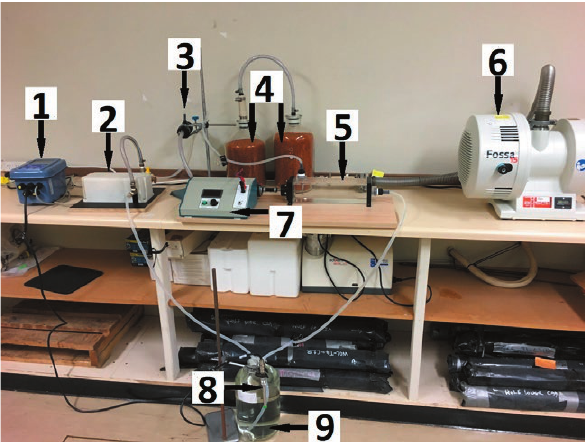
Figure 1. Photograph of the system used to study the effect of degassing on cavitation. (1) M700 process analysis system (to moni- tor DO levels); (2) Hollow fibre membrane; (3) Water pump; (4) Silica gel tanks; (5) Observation cell; (6) Vacuum pump; (7) Vari- able motor; (8) DO electrode; (9) Degassed water